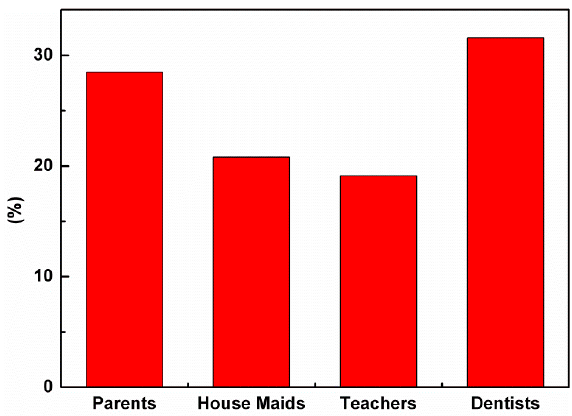
Figure 1. Source of oral health information.